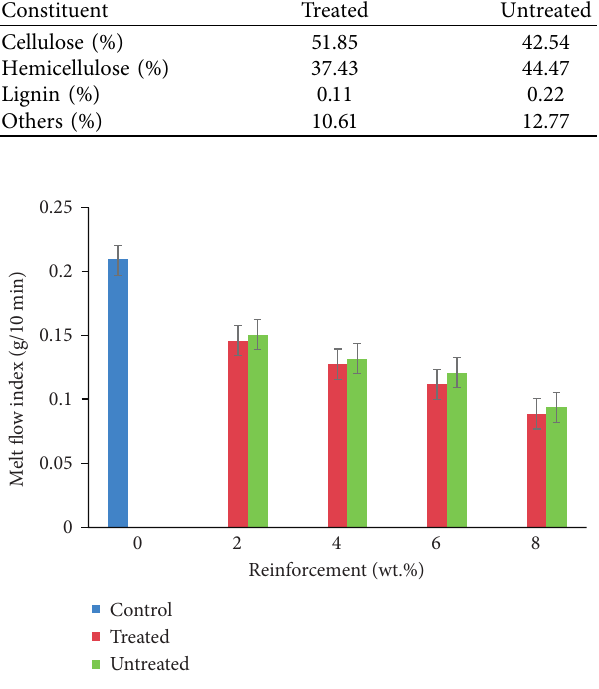
Figure 2: Variation in melt flow index of coir fibre and yam peel particulate polyethylene composite.